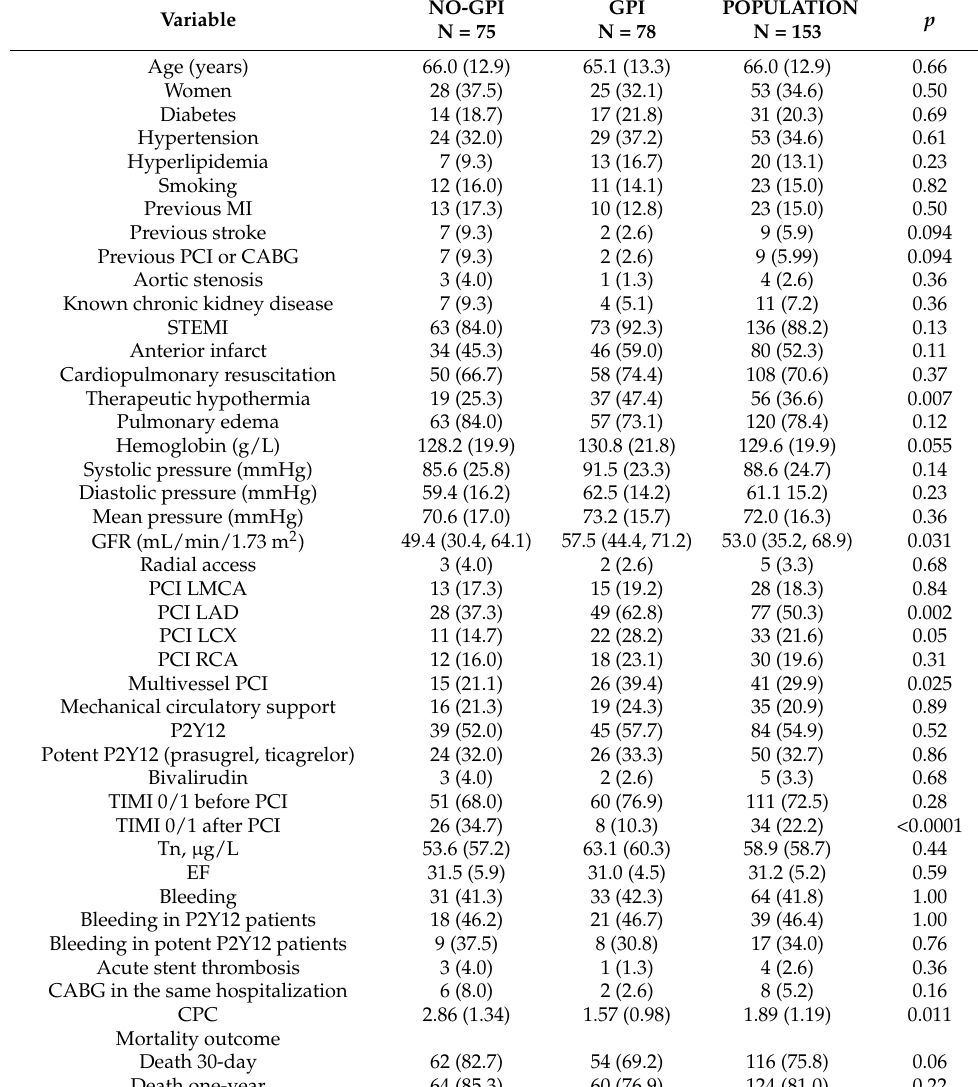
Table 1. Baseline and procedural characteristics of the study